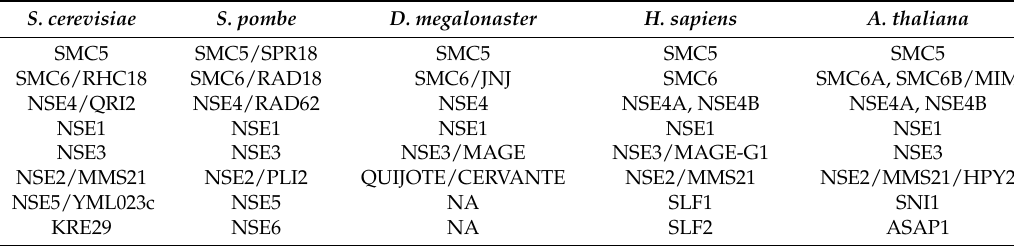
Table 1. Overview of Structural maintenance of chromosomes (SMC) complex 5/6 subunits in budding yeast ( Saccharomyces cerevisiae ), fission yeast ( Schizosaccharomyces pombe ), fruit fly ( Drosophila melanogaster ), human ( Homo sapiens ) and Arabidopsis ( Arabidopsis thaliana ). NA-information not